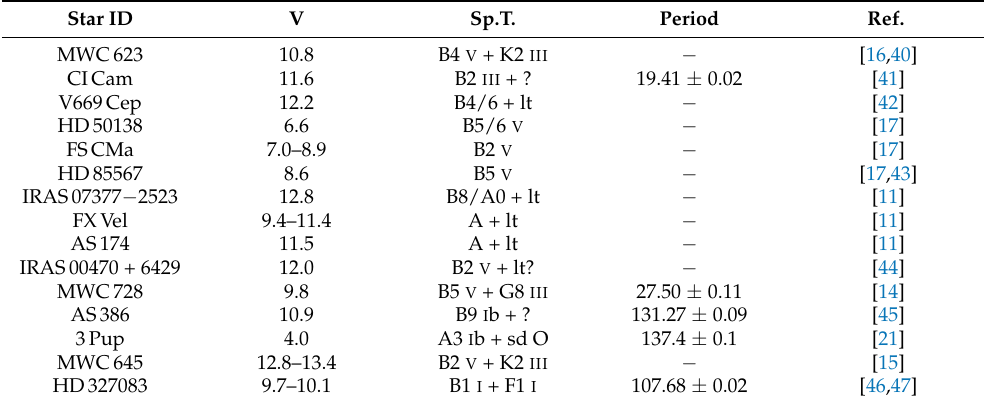
Table 2. Detected or suspected FSCMa-type binary systems. Star